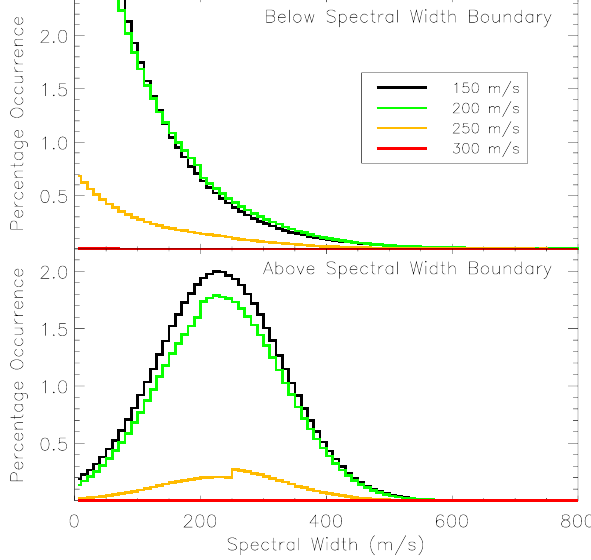
Fig. 9. The variation of the percentage of identified boundaries and the rms boundary error with changing spectral width threshold, as estimated by the application of algorithm 3 to the simulated data set.